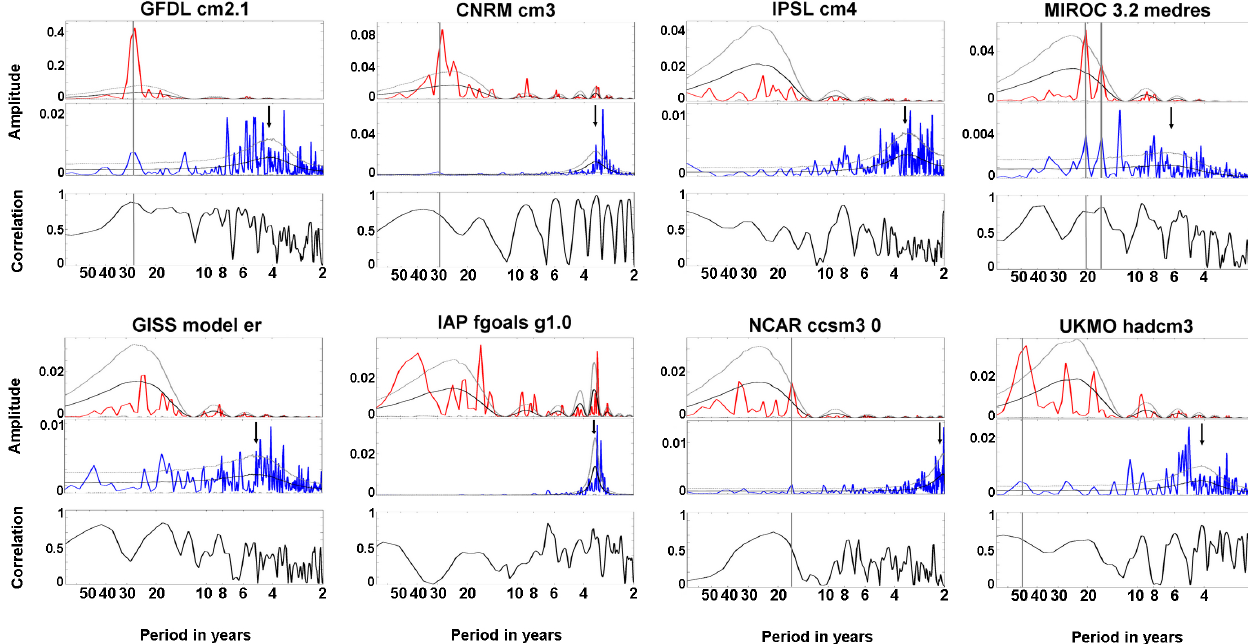
Fig. 7. Power spectra of the box B sea level trends computed over successive 17-yr windows and NINO3 index from the coupled climate model control runs. Top panels: power spectra of box B 17-yr sea level trends (solid red line). They are shown together with the 17-yr trend of the best fit AR2 null hypothesis (solid black line) and the 95% confidence levels(dashed grey line). Middle panels: power spectra of the NINO3 index (solid blue line), shown together with the best fit AR2 null hypothesis (solid black line) and the 95% confidence levels(dashed grey line). Bottom Panels: magnitude squared coherence between the box B 17-yr sea level trends and their respective NINO3